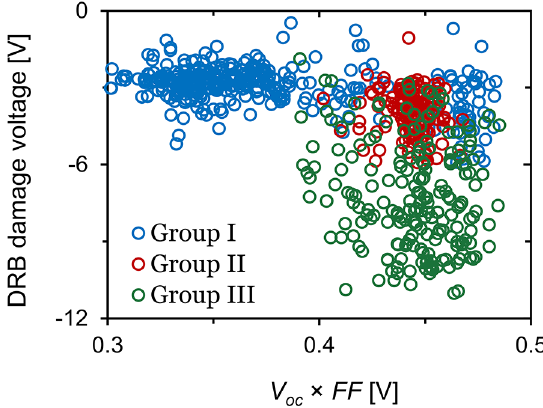
Fig. 6. Plot of all cells of groups I, II and III, that were damaged during a dark reverse bias sweep. On the x -axis the V oc (cid:3) FF value, and on the y -axis the damage voltage in the dark is